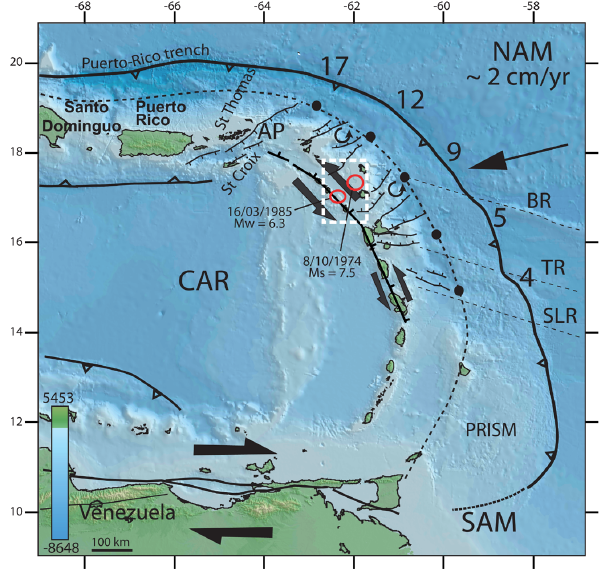
Fig. 1. Major active tectonic structures of the Lesser Antilles Arc (modified after Feuillet et al., 2011b and from Lopez et al. (2006). NAM: North America Plate; SAM: South America Plate; CAR: Caribbean Plate; AP: Anegada Passage; BR: Barracuda Rise; TR: Tiburon Rise. (red circles: location of possible major earthquakes responsible of the analyzed sedimentary event; white rectangle: studied